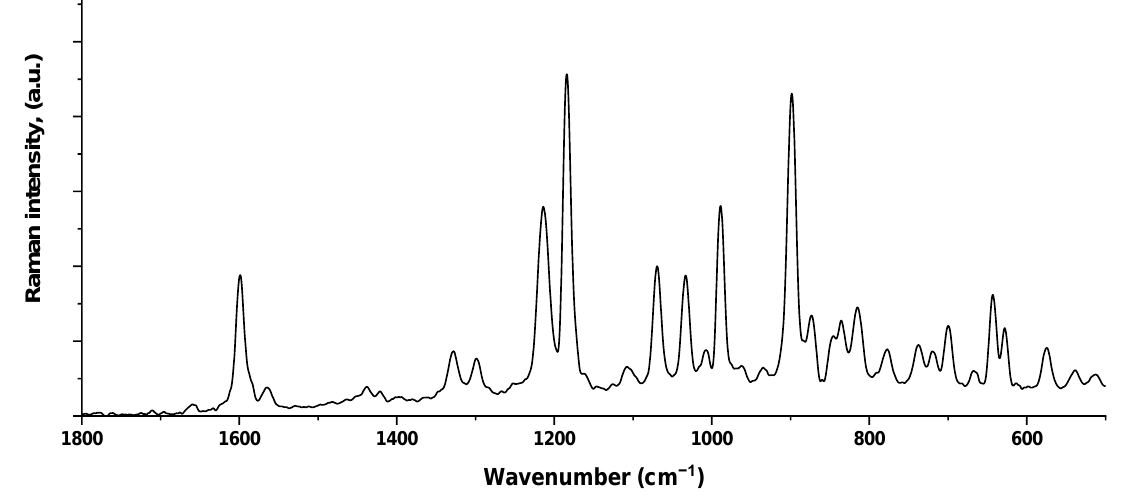
Figure 3. FT-Raman spectrum of BBP. Table 1. Assignments of FT-IR; theoretical FT-IR and FT-Raman spectral bands for BBP.